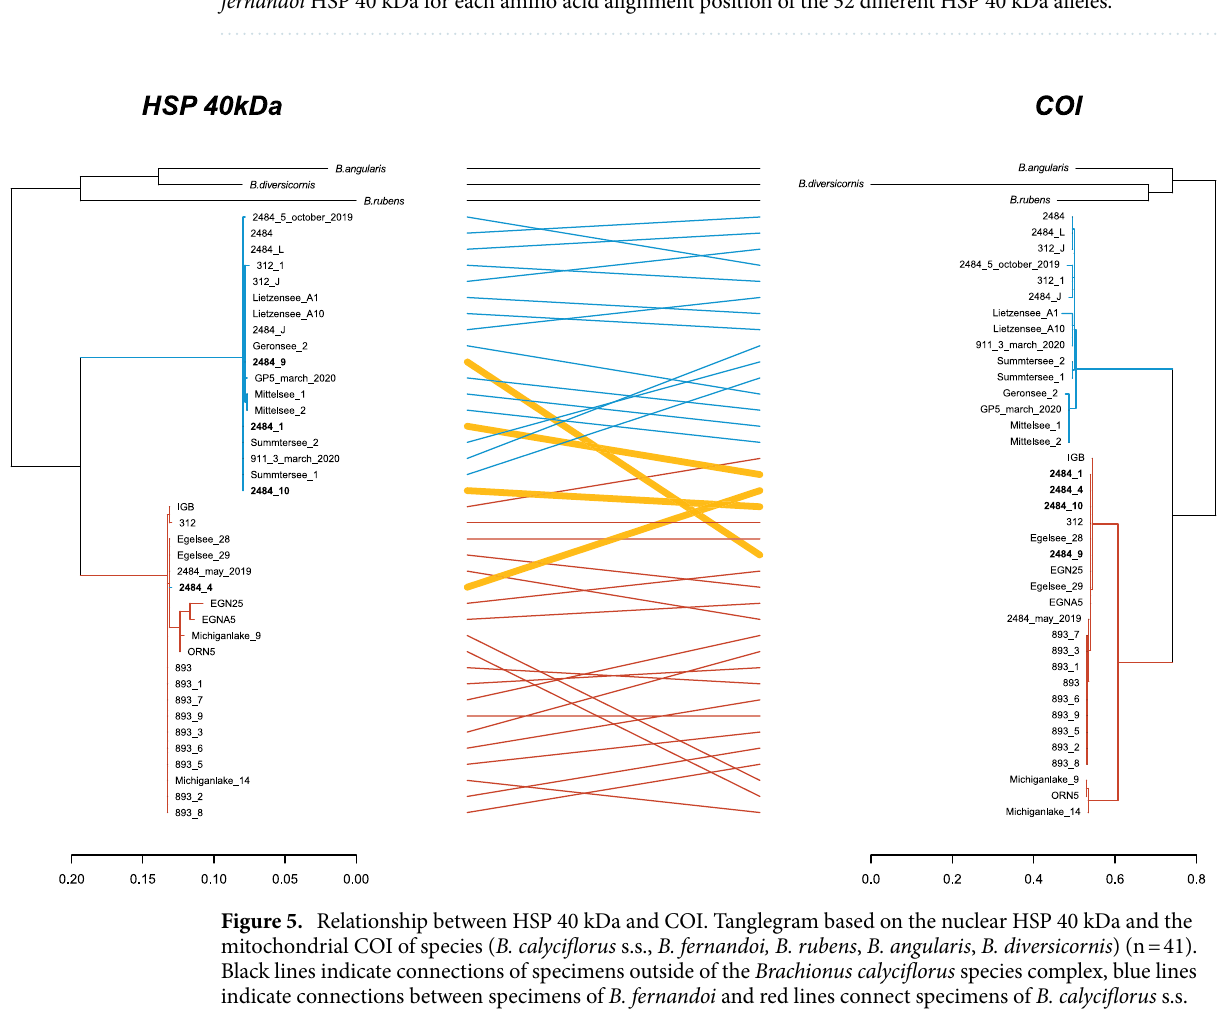
Figure 5. Relationship between HSP 40 kDa and COI. Tanglegram based on the nuclear HSP 40 kDa and the mitochondrial COI of species ( B. calyciflorus s.s., B. fernandoi, B. rubens , B. angularis , B. diversicornis ) (n = 41). Black lines indicate connections of specimens outside of the Brachionus calyciflorus species complex, blue lines indicate connections between specimens of B. fernandoi and red lines connect specimens of B. calyciflorus s.s. Yellow coloured connections indicate specimens originating from an introgression/hybridization event between B. calyciflorus s.s. and B. fernandoi . They all occurred at the same location and all carried a B. fernandoi ITS sequence